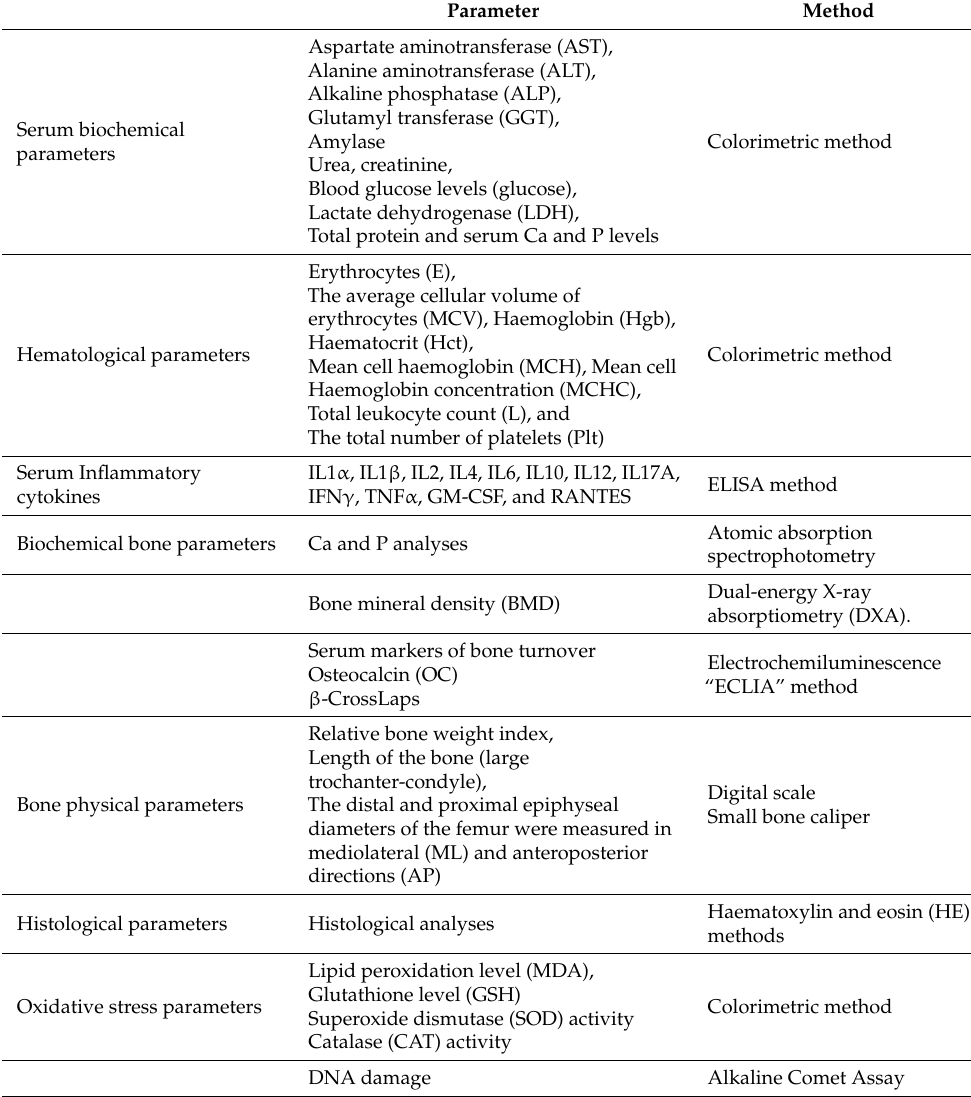
Table 5. Parameters analysed and methods used for their determination in osteoporotic